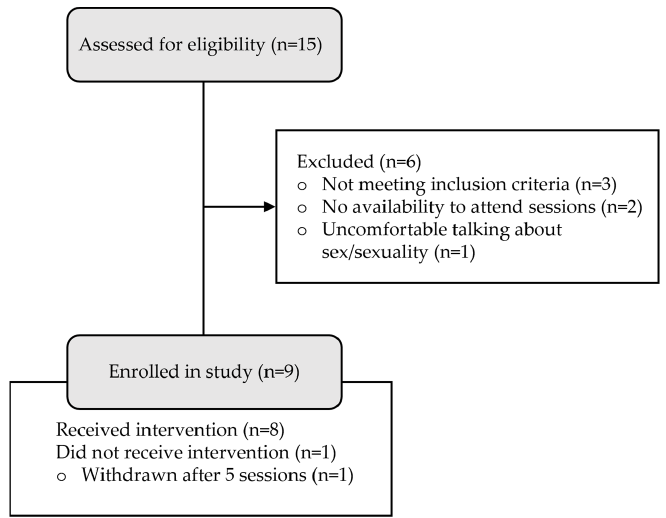
Figure 1. Recruitment and flow of participants throughout the study. Table 1. Demographic, injury, and cognitive characteristics of the participants.